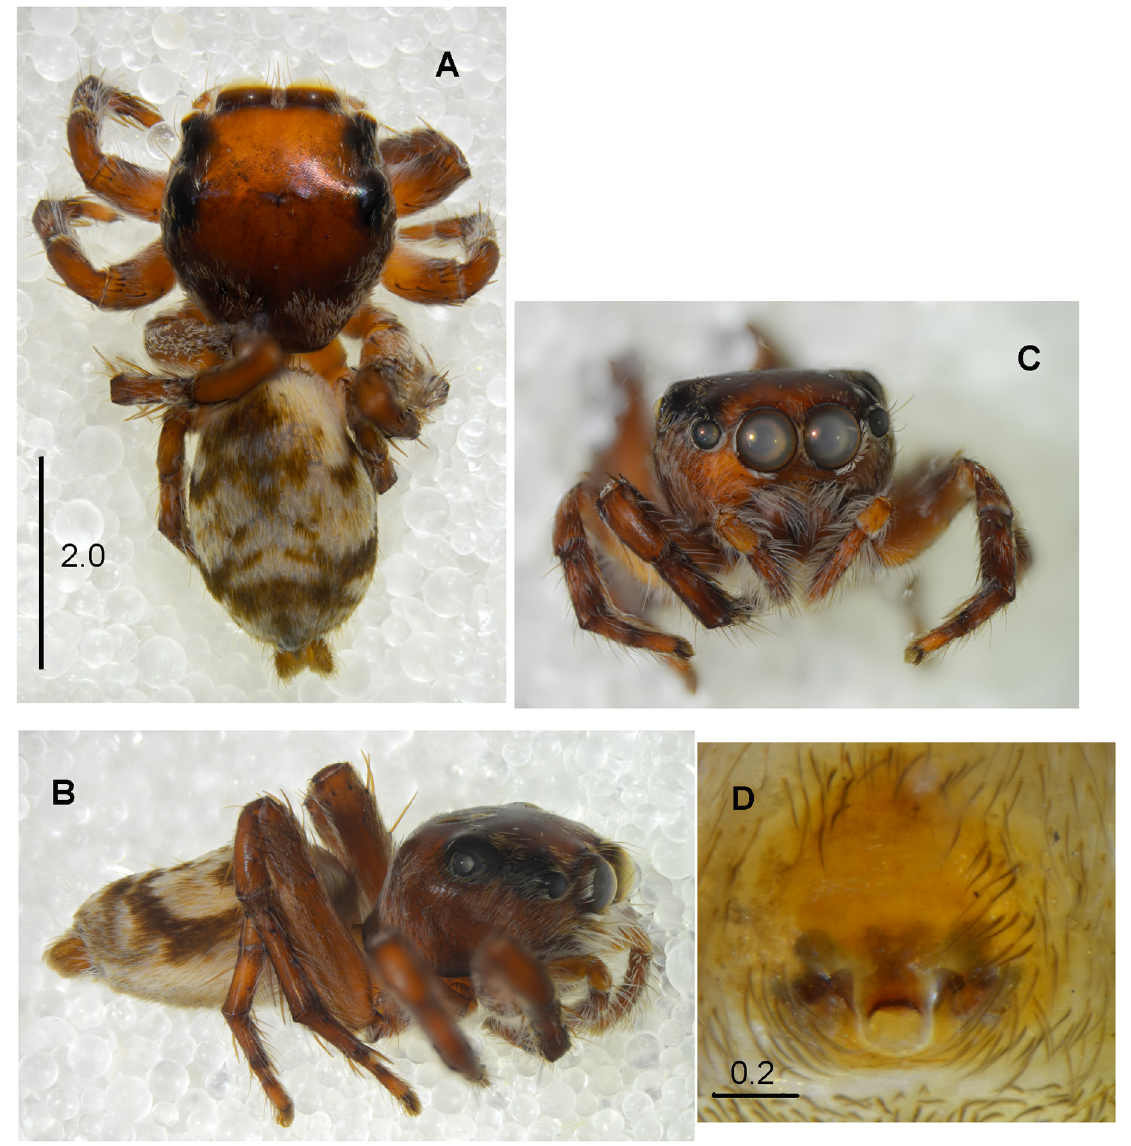
Fig. 29. Iranattus principalis (Wesołowska, 1999), ♀ (MNHN). A . Habitus, dorsal view. B . Habitus, lateral view. C . Frontal view. D .